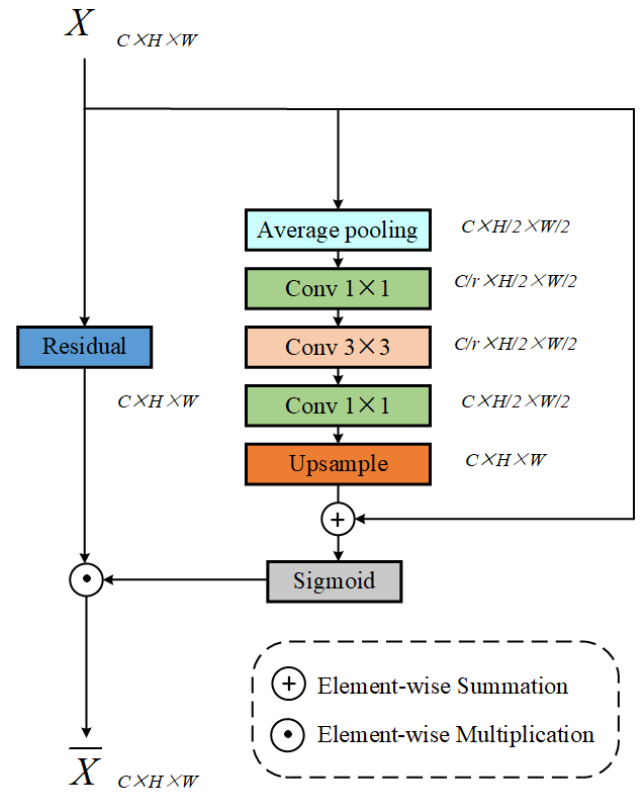
Figure 4. Schema of the self channel attention (SCA) block, where C , H , and W represent the number of channels, height, and width of the feature map, respectively. r is a reduction ratio used to vary the capacity. For simplicity, we denote convolution as Conv while omitting normalization and activation layer after each convolution